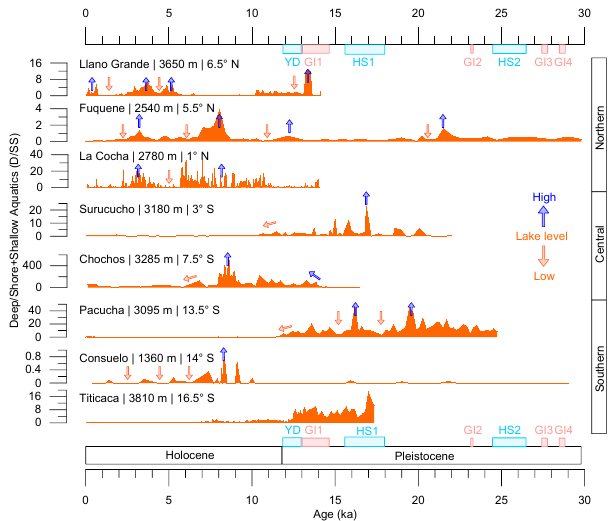
Figure 4. Temporal changes in the ratio of aquatic taxa charac- teristic of deep water to taxa from shallow water and wet shores (D / SS) for selected sites in the tropical Andes (Fig. 1, Table 1). Site name, elevation rounded up to the nearest 5m, and latitude to the nearest half degree are shown next to each record. Heinrich sta- dials (HS) are drawn for reference as defined by Sánchez-Goñi and Harrison (2010). The Younger Dryas (YD) follows the timing of Greenland stadial 1 (Rasmussen et al., 2006) and the chronozone defined by Mangerud et al. (1974). The timing of Greenland inter- stadials (GI) is based on Wolff et al.